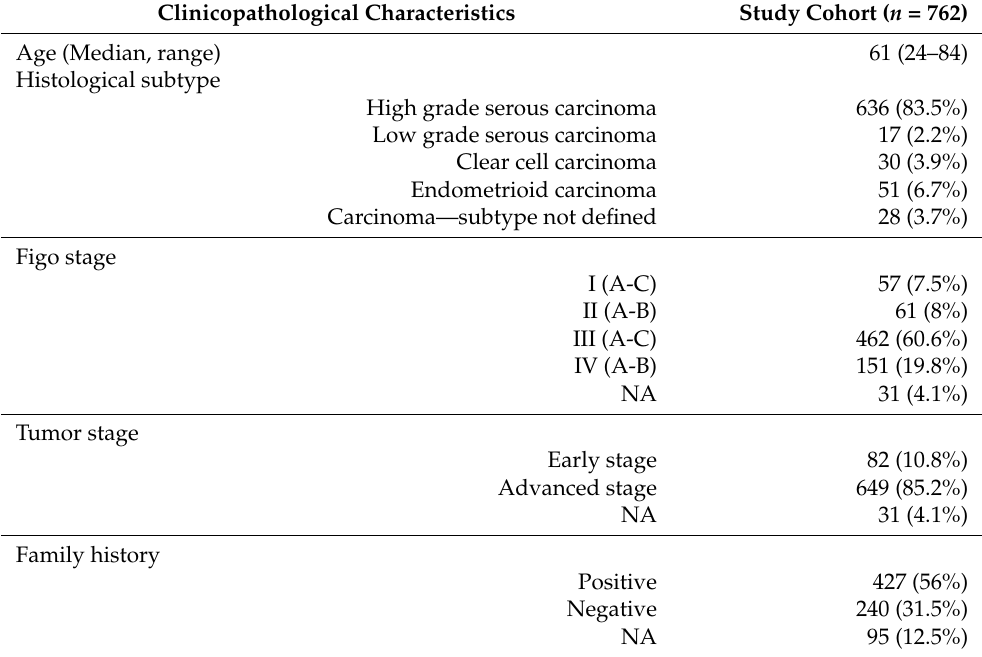
Table 1. Clinicopathological characteristics of the study